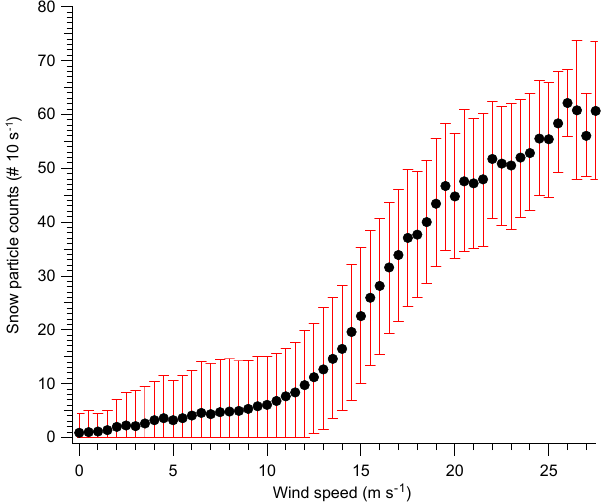
Figure 5. Particle counts from the Lighthouse OPC in the 200– 500nm size bin as a function of wind speed. Raw data (grey) and the averaged count and standard deviation for each wind speed in a 1ms − 1 bin shown in red. The black line denotes 8ms − 1